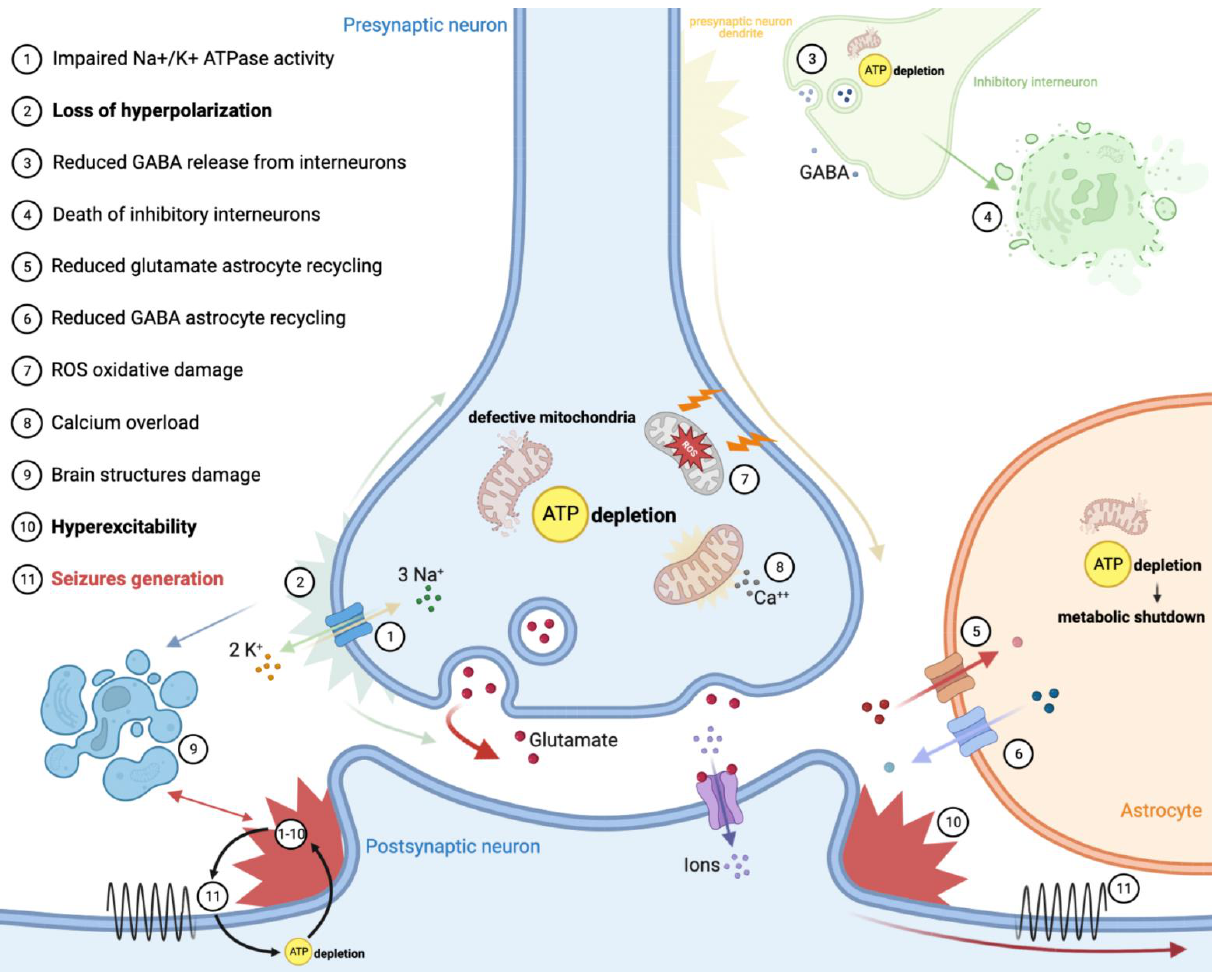
Figure 1. Epilepsy pathomechanism in primary mitochondrial diseases.